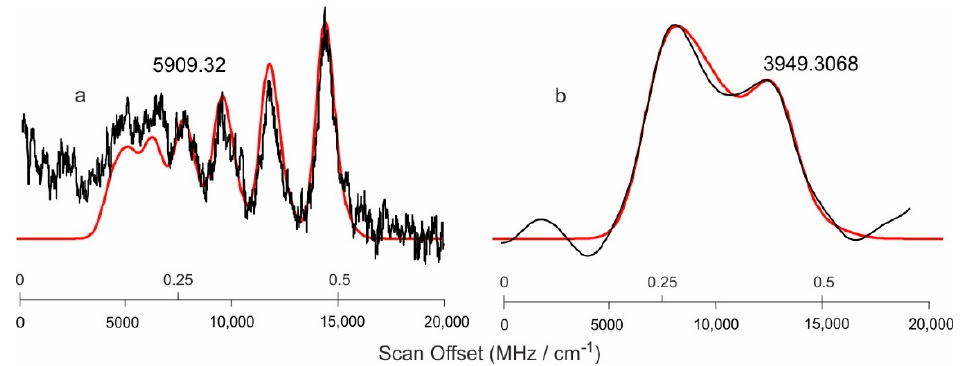
Figure 6. Confirmation of the existence of the new odd-parity level at 35,233.558 cm − 1 . Black line—experiment, red line—simulation. ( a ) Line 5909.32 Å. The signal-to-noise-ratio of the OG signal is not very good, and a drift of the background signal occurred. Nevertheless, the hf pattern fits well to the one predicted from the hf constants of the combining levels. Full width at half maximum (FWHM) of the simulated pattern 900 MHz. ( b ) Line 3949.3068 Å as observed in the FT spectrum [22,23]. FWHM of the simulated pattern 2200 MHz.